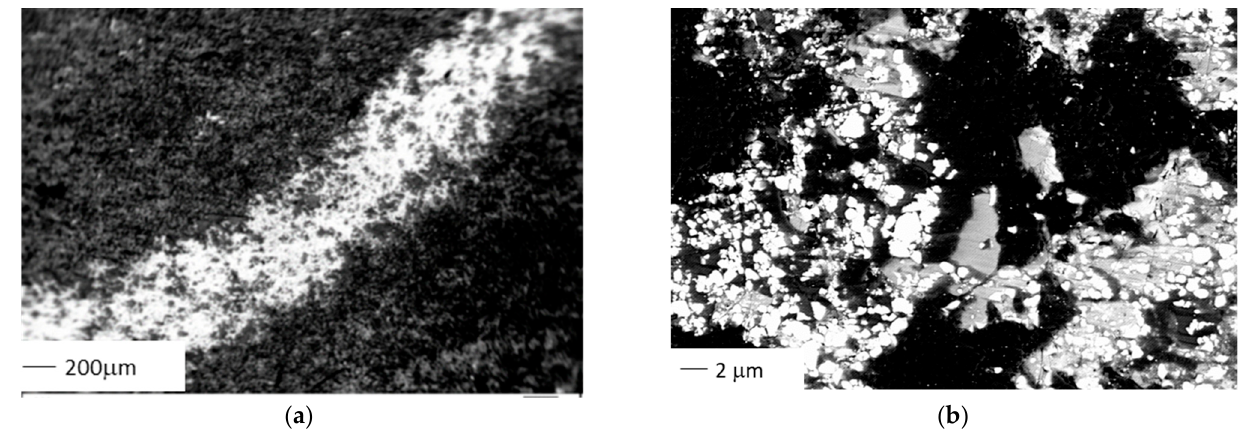
Figure 10. SEM micrograph ( a ) and a magnification ( b ) of wear tracks of WC-Cr 3 C 2 -Ni.